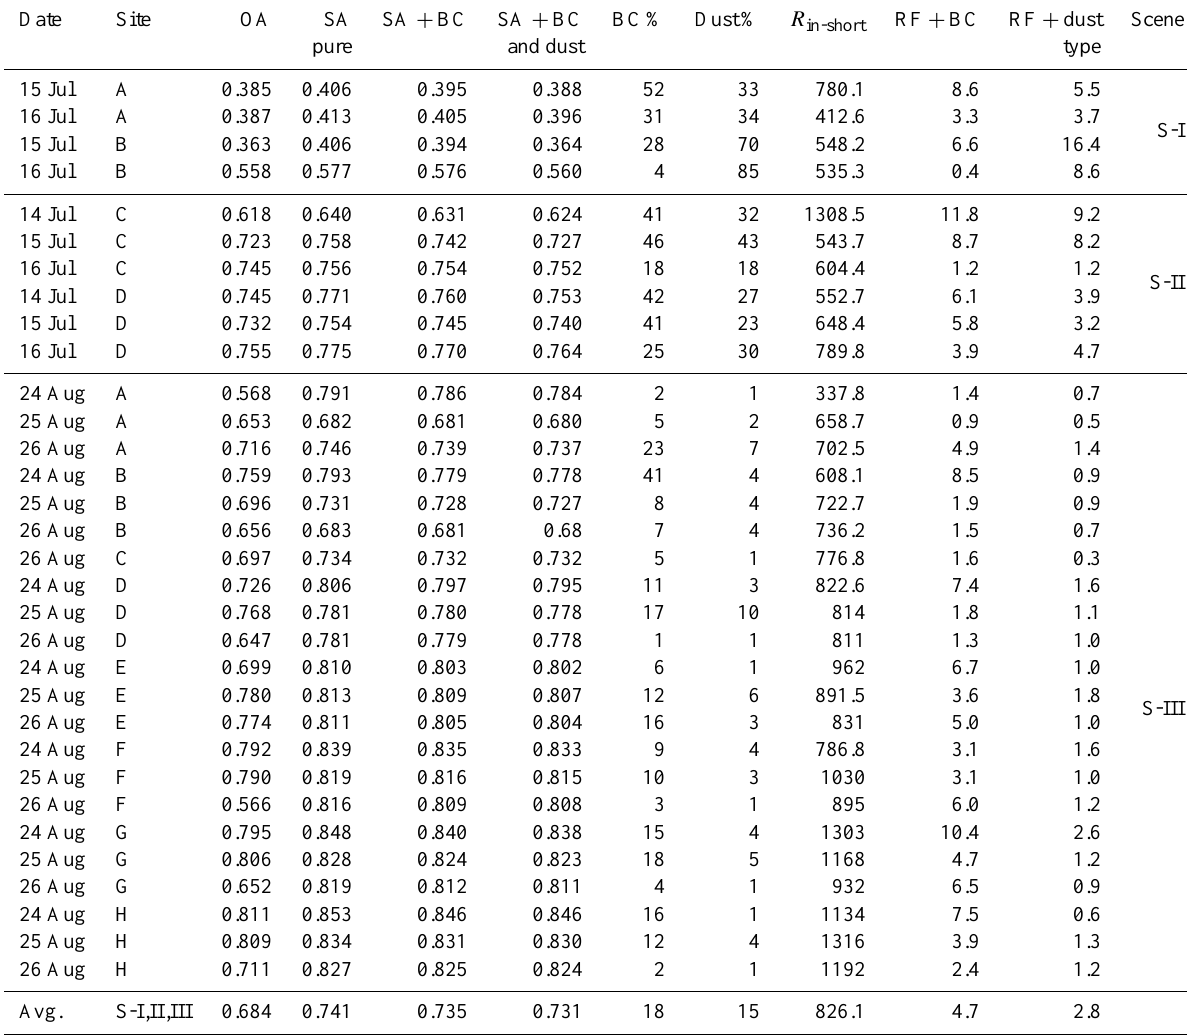
Table 2. Sensitivity analysis with the SNICAR model. BC% and Dust% are the contributions of BC and dust to the total reduction of the albedo, respectively. R in-short is the incident solar radiation measured by